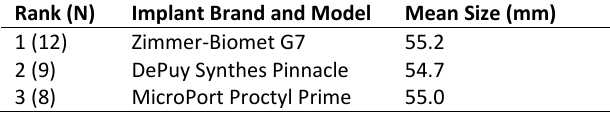
Table IIb. The three most commonly implanted metallic acetabular cups.